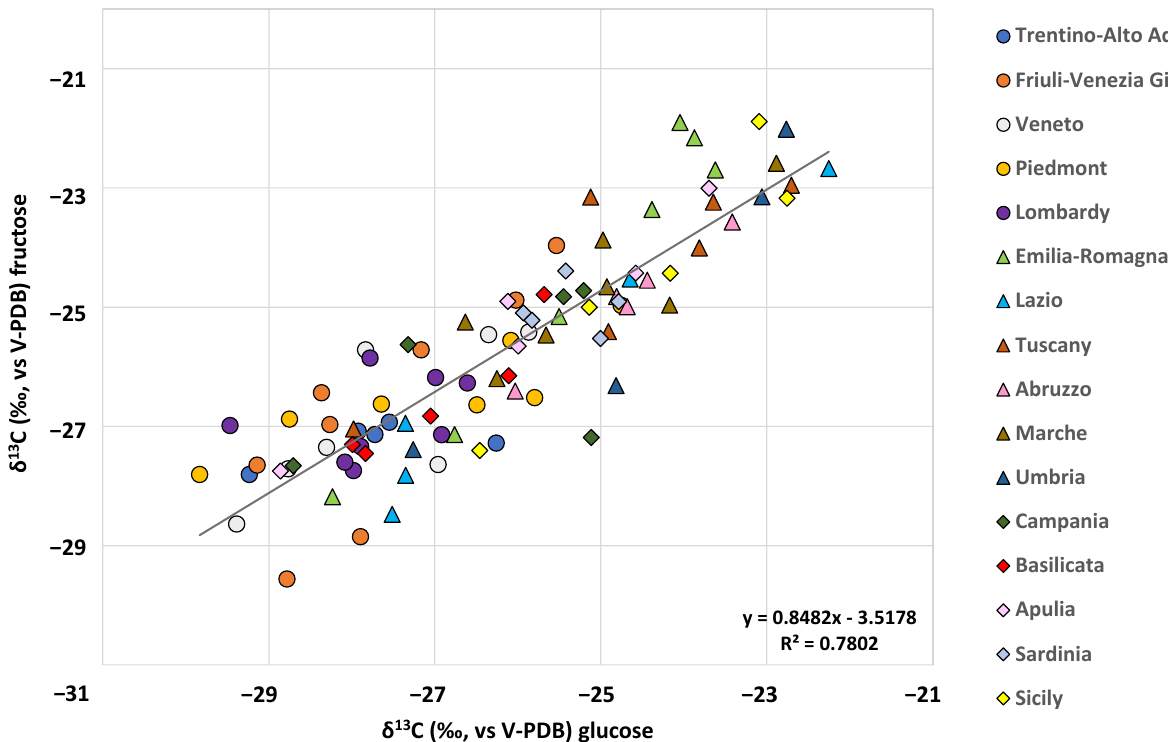
Figure 2. Correlation between δ 13 C FRUCTOSE and δ 13 C GLUCOSE.